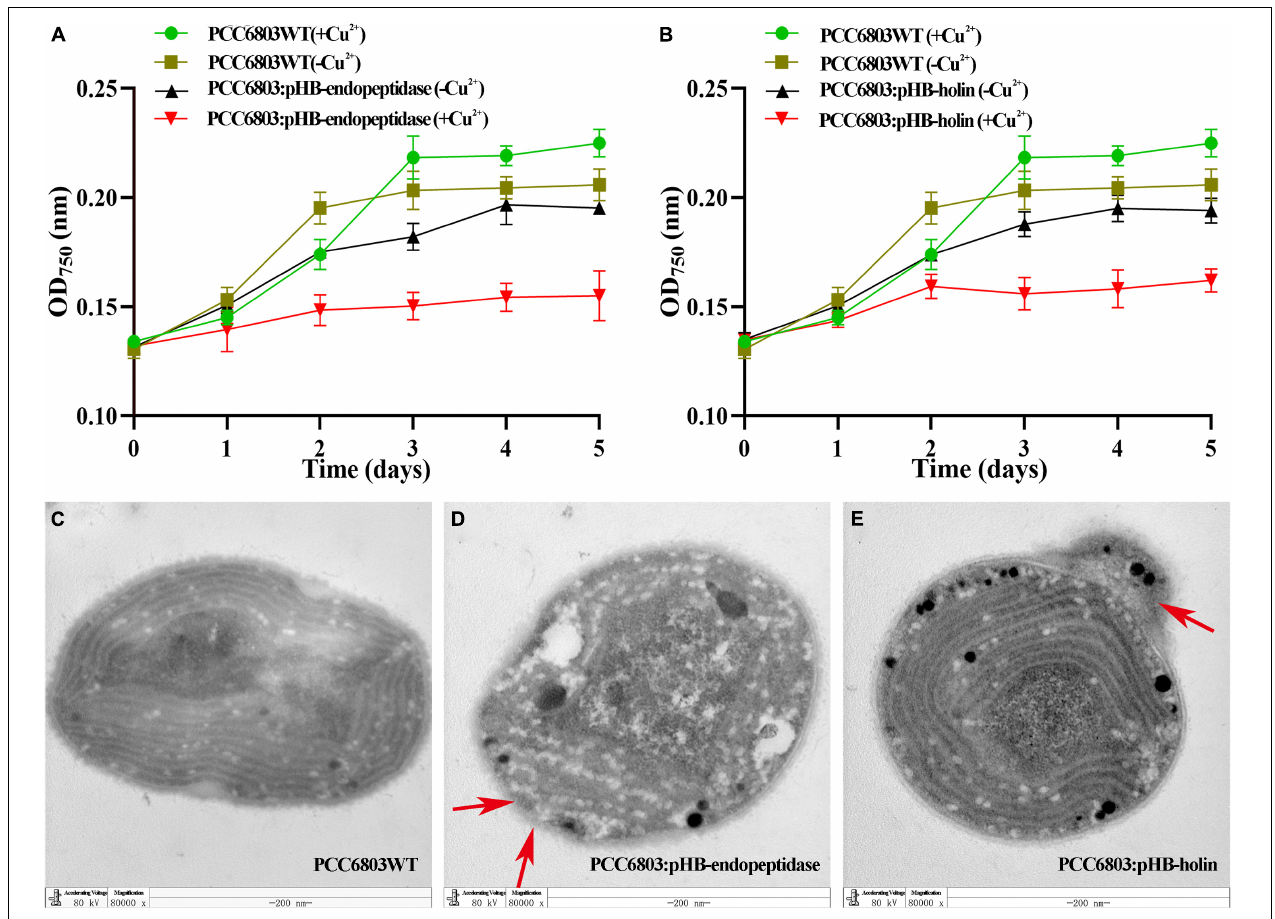
FIGURE 5 | Growth curves and transmission electron microscopy (TEM) observation of recombinant cyanobacteria. (A) The growth curves of induced and uninduced strains (PCC6803WT and PCC6803: pHB-endopeptidase). (B) The growth curves of induced and uninduced strains (PCC6803WT and PCC6803: pHB-holin). The data were shown as means ± standard deviation from three independent experiments. (C) Induced PCC6803WT under TEM. (D) Induced PCC6803: pHB-endopeptidase under TEM. (E) Induced PCC6803: pHB-holin under TEM. Red arrows in panels (D,E) indicate morphological